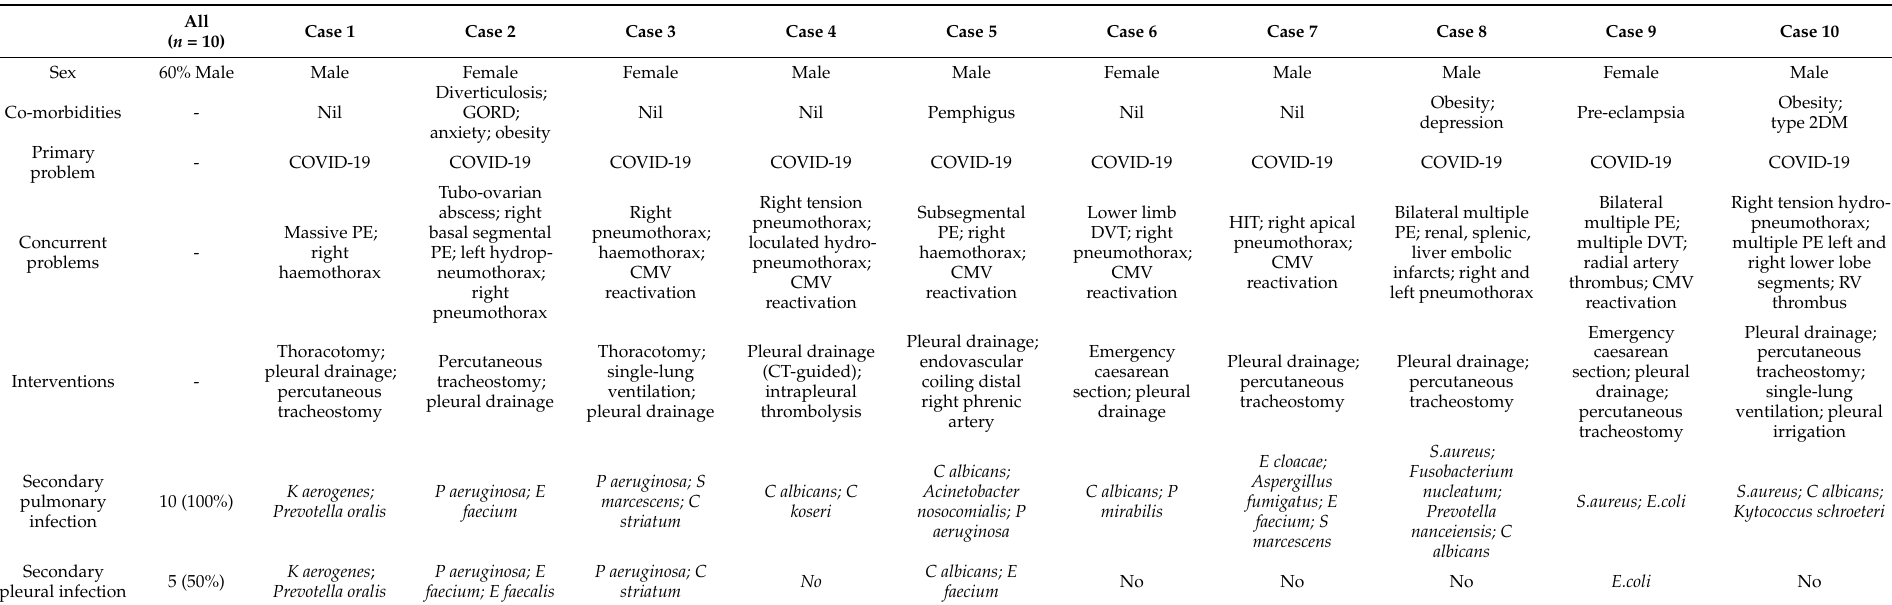
Table 1. Demographics and admission